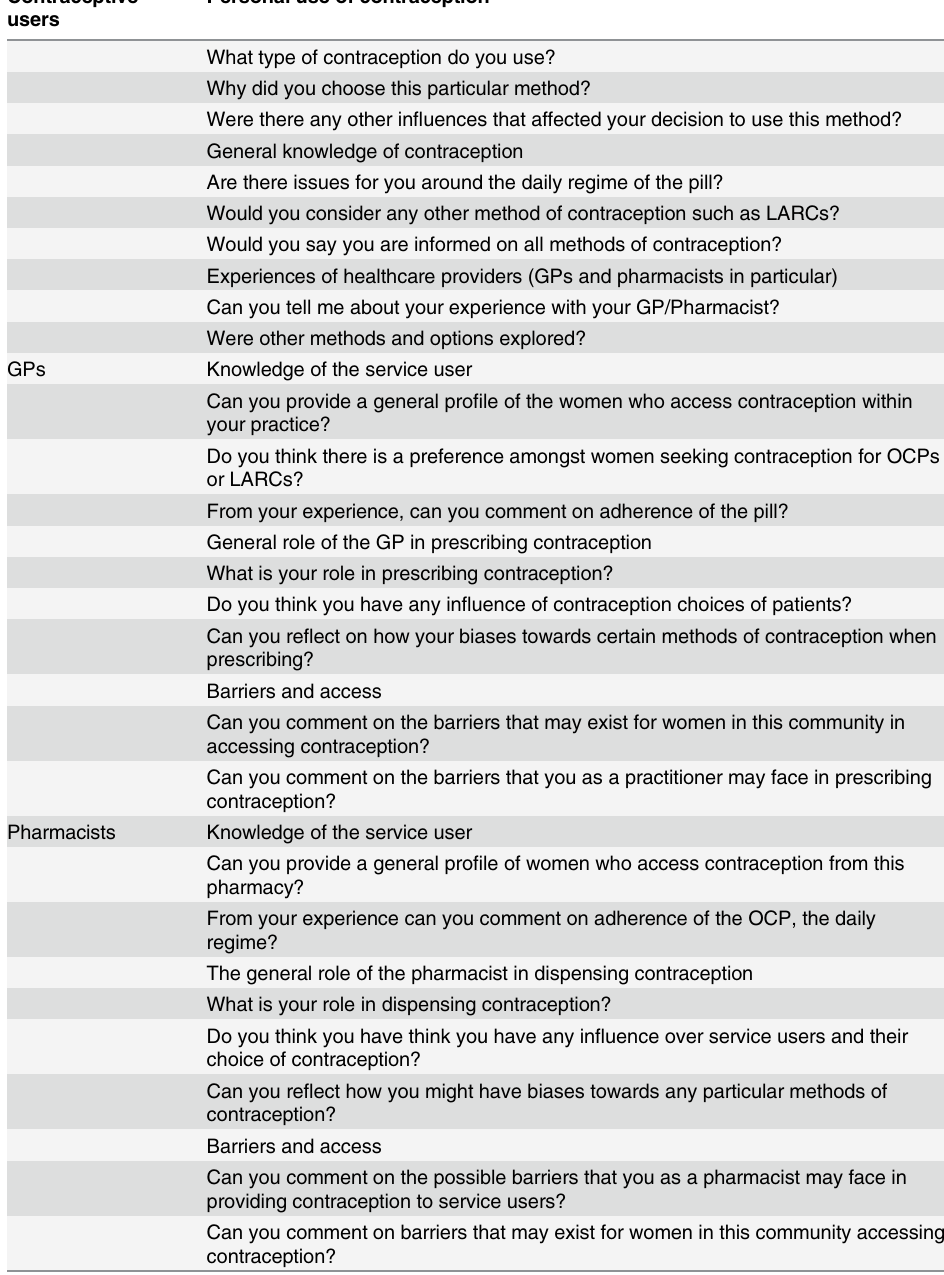
Table 1. Interview topic